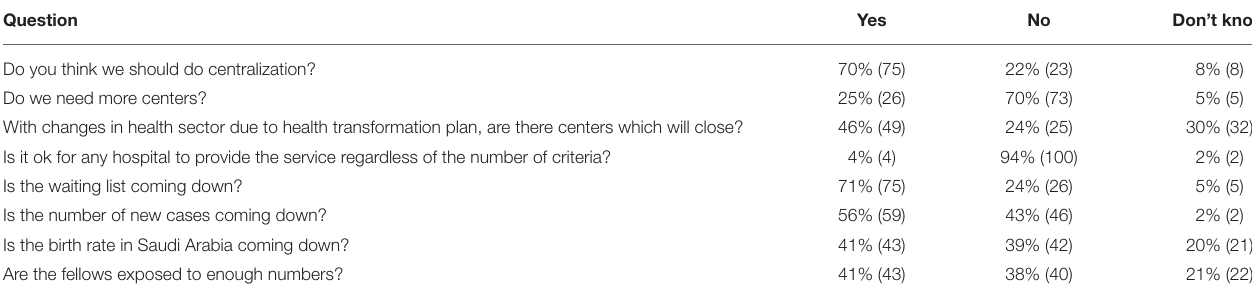
TABLE 2 | Showing the summary of the participant responses to our main survey questions. Question Yes No Don’t know Do you think we should do